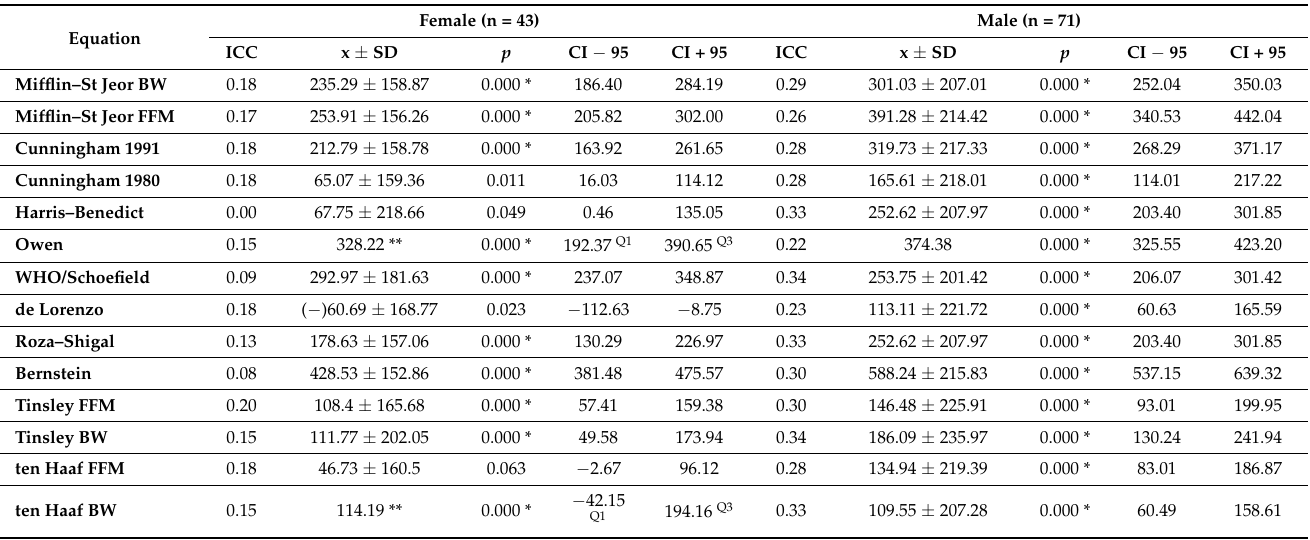
Table 3. Comparison of the differences between the results calculated with predictive equations and by ICC. Here, x = RMR – C, where C is the calculated metabolic